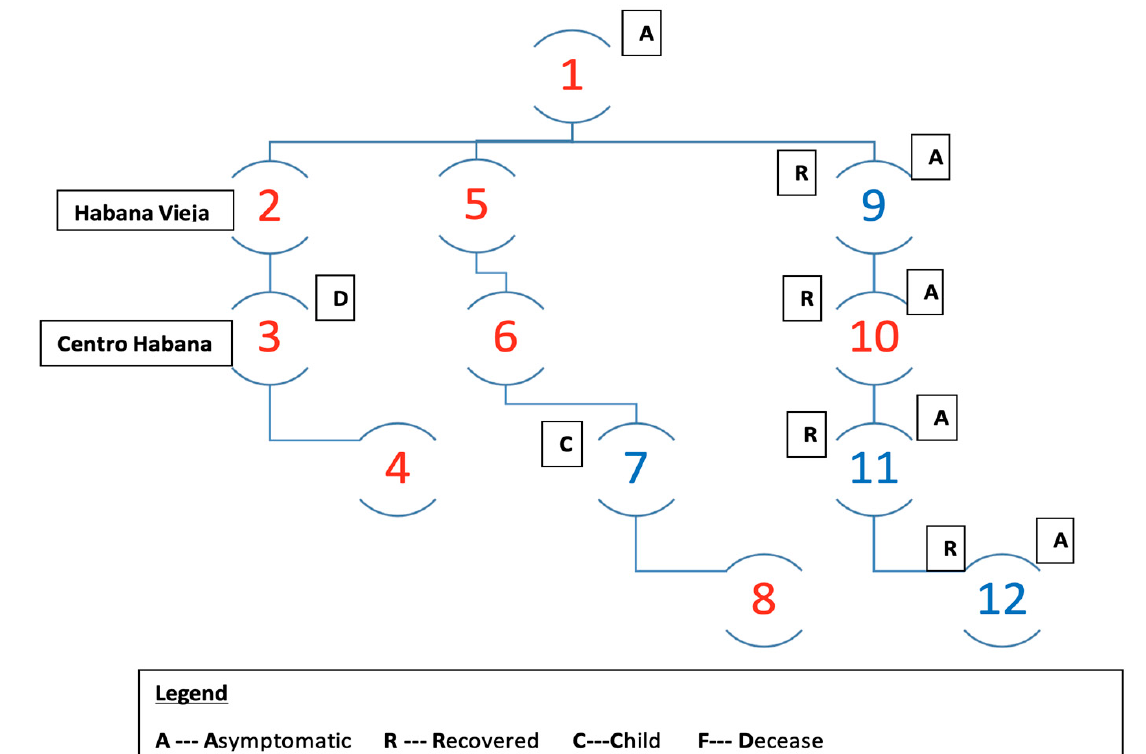
Figure 4. Example of contagion chains.